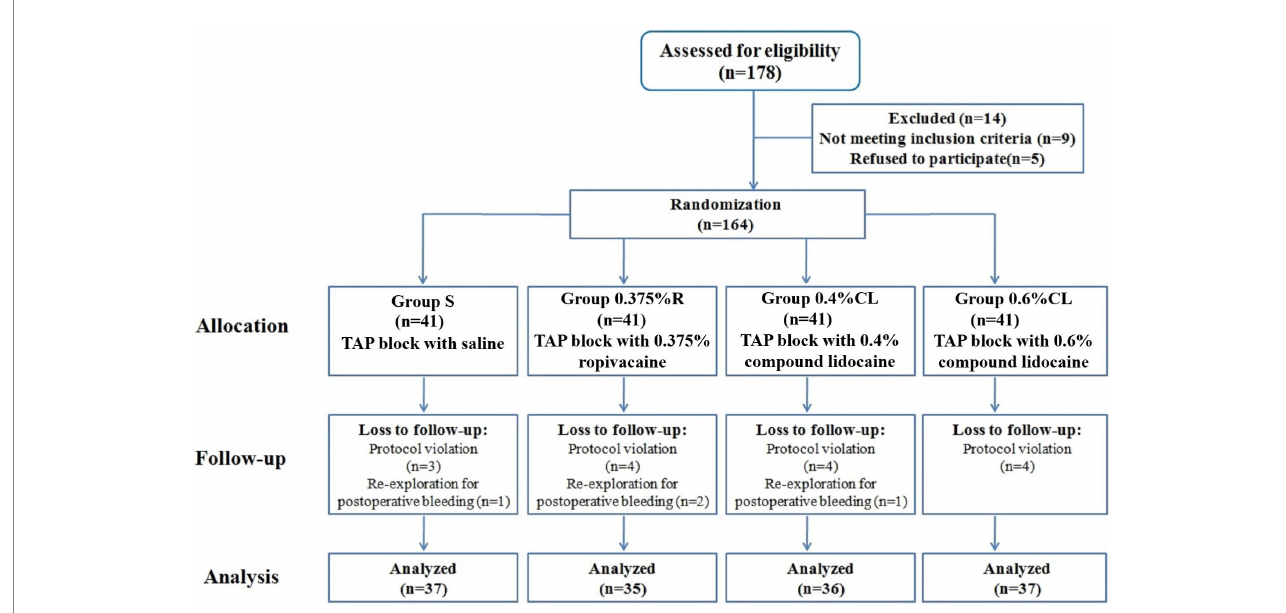
FIGURE 1 Consolidated standards of reporting trials (CONSORT) flow